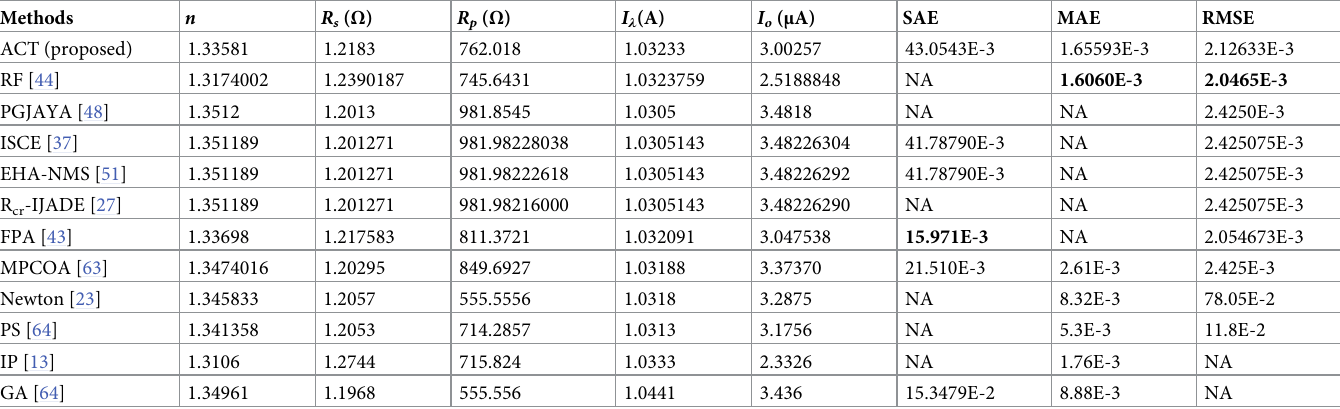
Table 6. Comparison of ACT with other existing methods that extract different parameters of single-diode model intended for Photowatt-PWP201 module. Methods